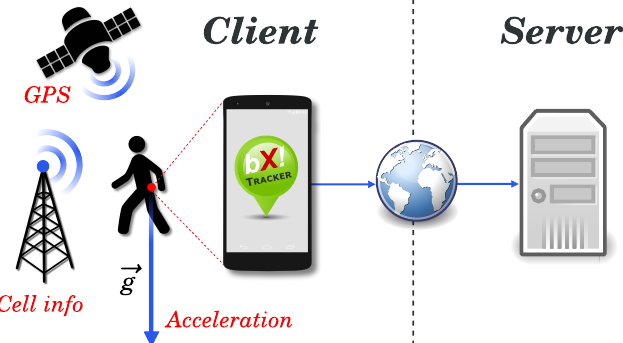
Figure 3. System overview. Pre-processed sensor data collected on mobile devices is periodically uploaded to the